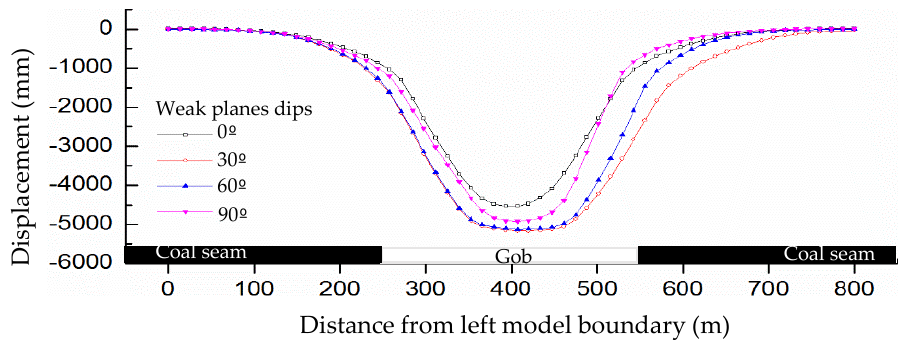
ff erent types of weak